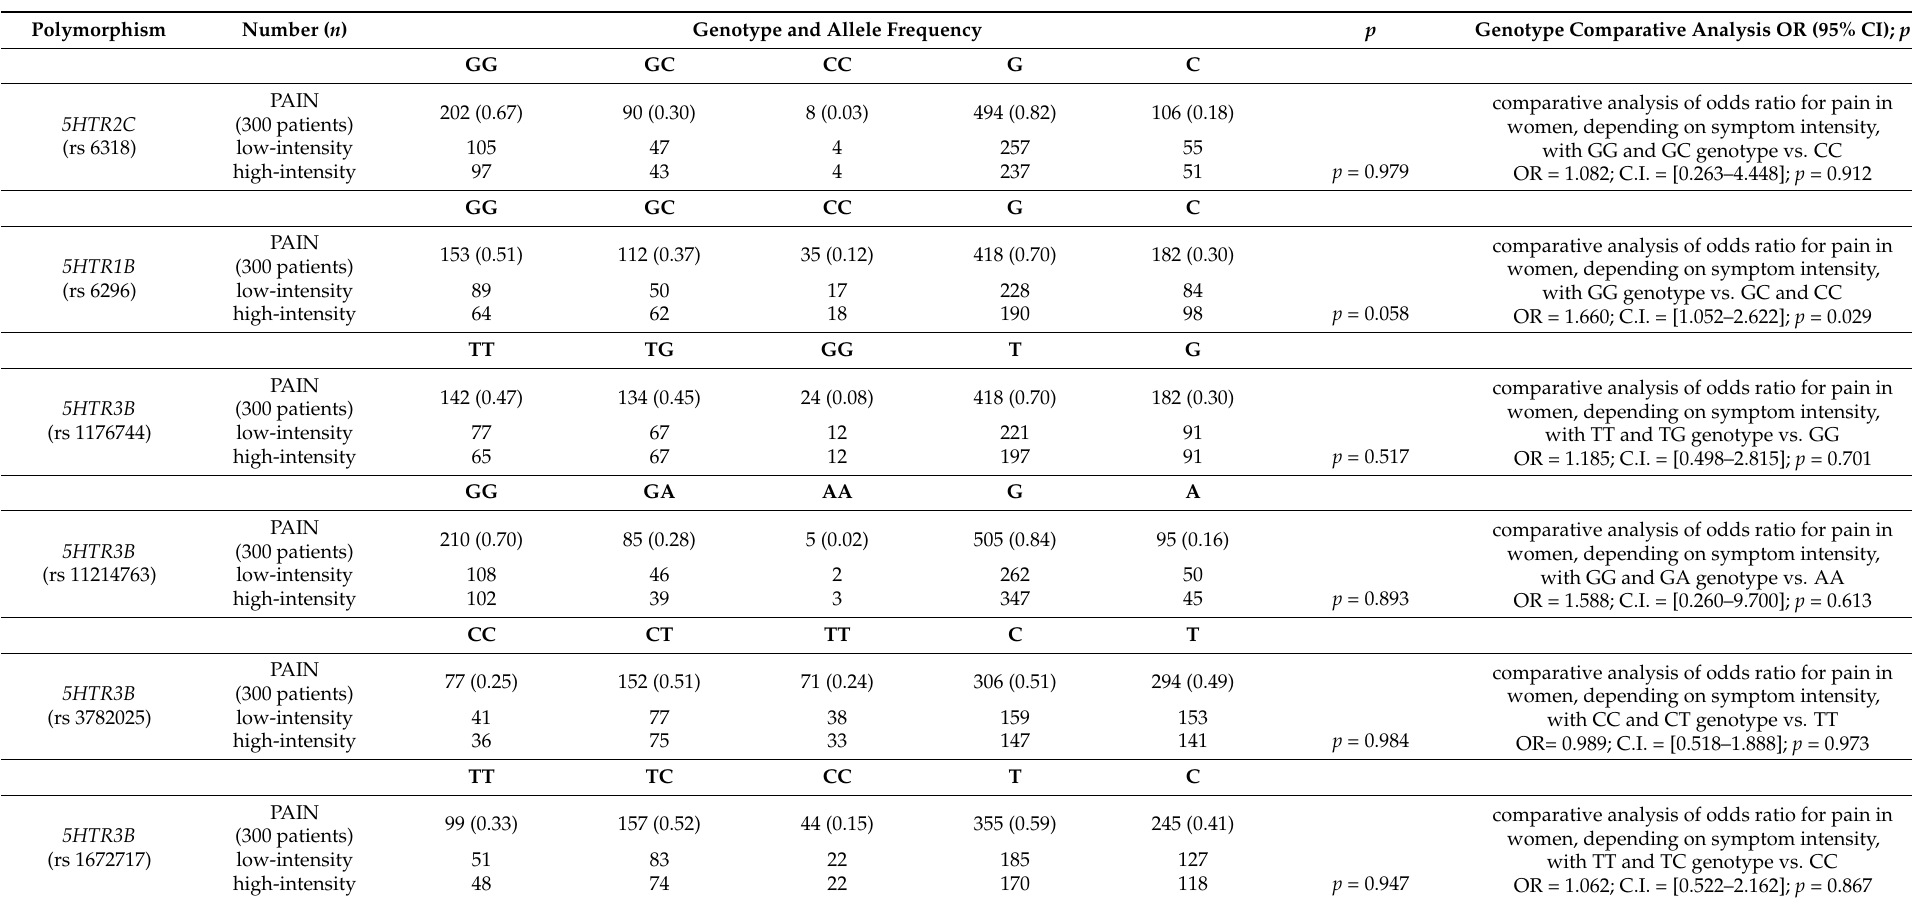
Table 3. Allele and genotype frequency of polymorphisms of encoding candidate genes in the etiology of postoperative pain in women undergoing hysteroscopy and gynecologic laparoscopy due to infertility, depending on symptom